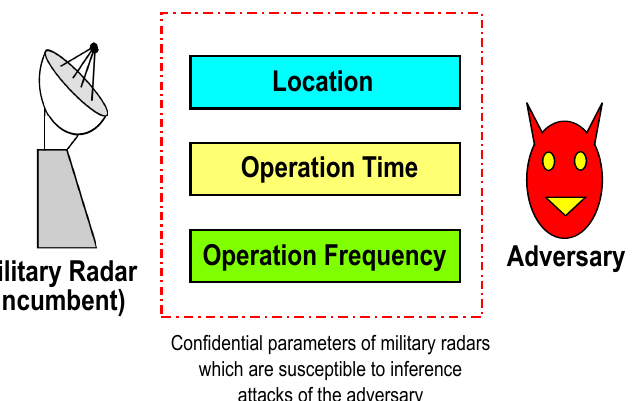
Figure 6. Confidential operational parameters of incumbents susceptible to inference attacks of the